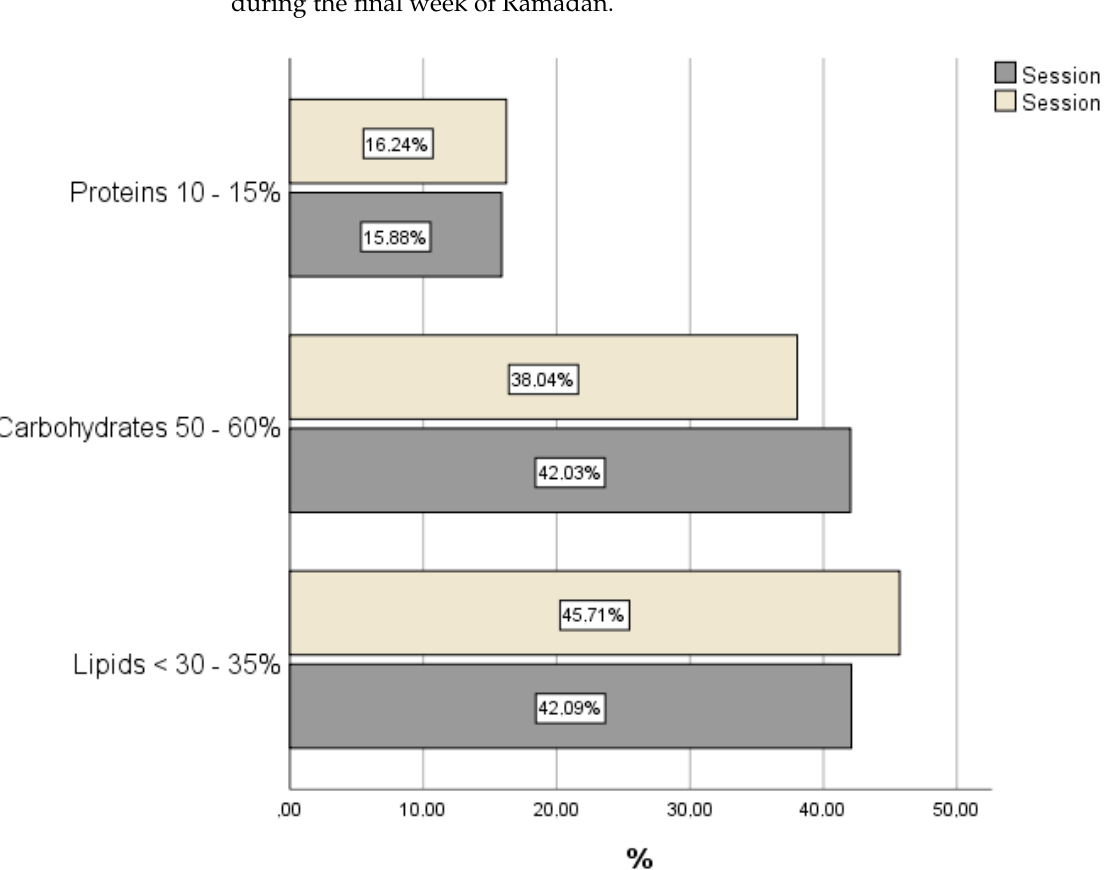
Figure 2 illustrates the imbalance in the caloric and lipid profiles recorded, before and during the final week of Ramadan.